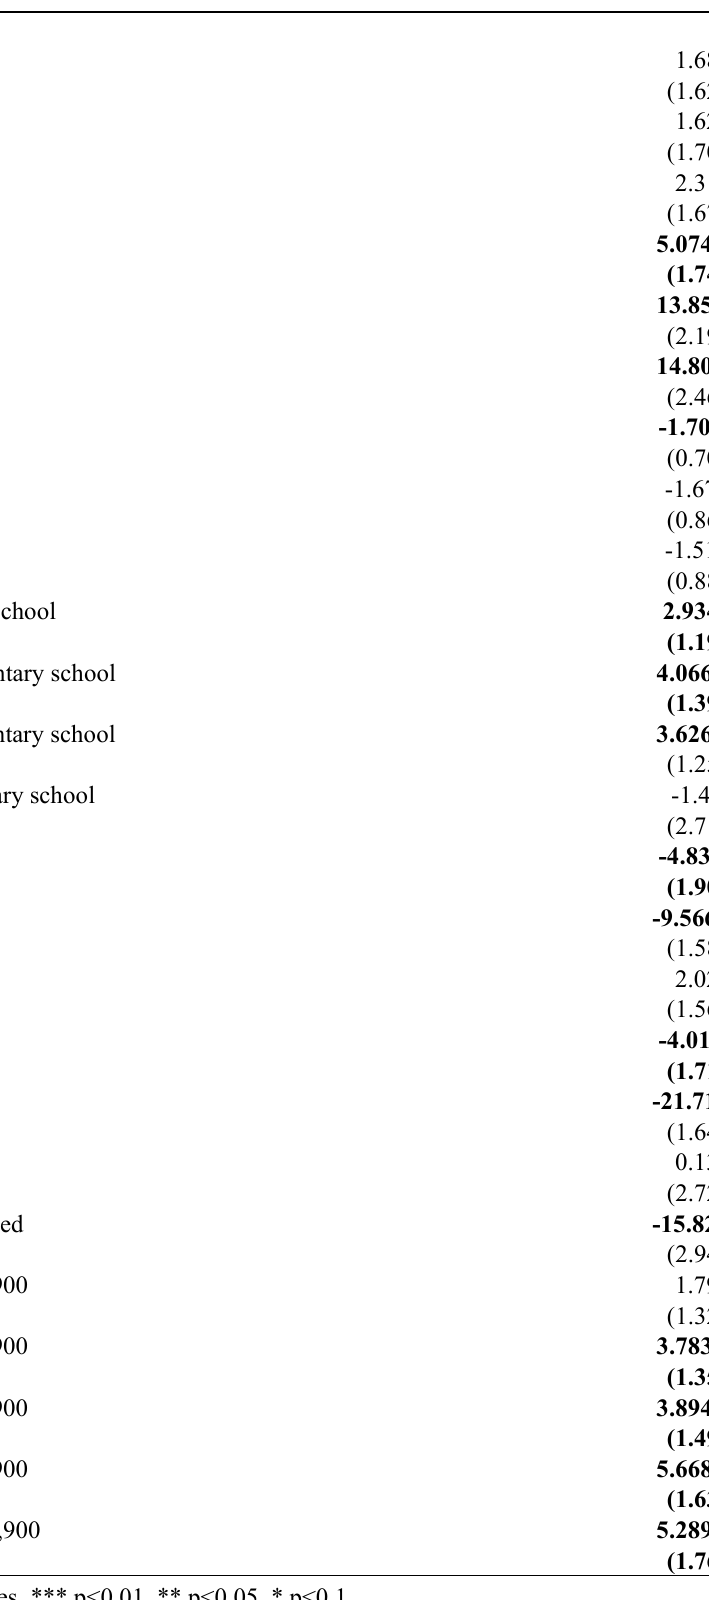
Table 2: Regressions of HRQoL on VAS scale, Pooled samples